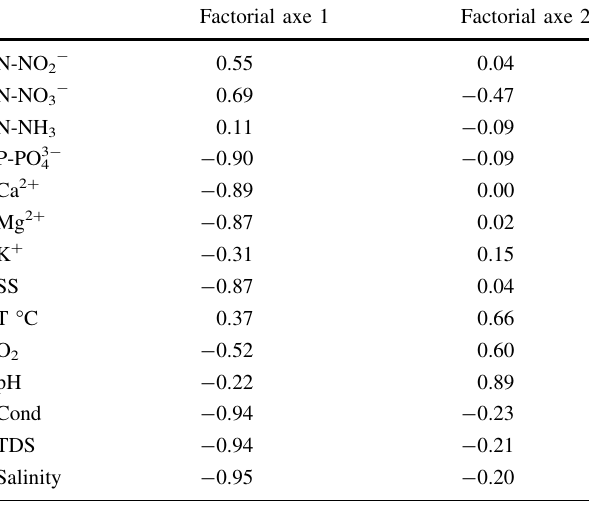
Fig. 2 Principal component analyses of treatments and their effect on water quality. a Correlation between chemical parameters; b classification of treatments Table 4 Correlation coefficients between variables and axis principal Factorial axe